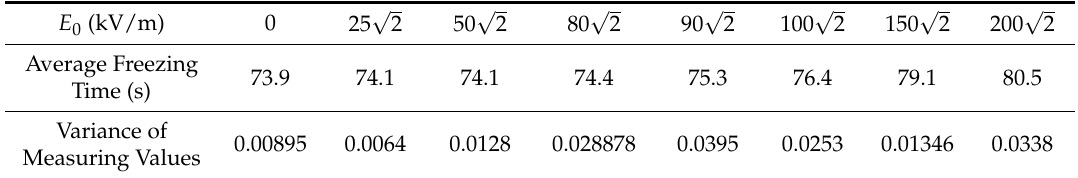
Table 1. Influence of the peak value of electric field ( E 0 ) on average freezing time.